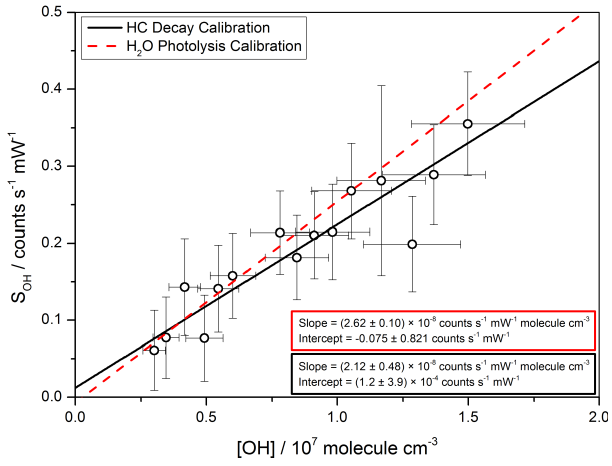
Figure 7. Calibration from the hydrocarbon decay method for cyclohexane at 1000mbar and 293K chamber pres- sure using the HIRAC FAGE instrument with the 200Hz PRF laser system; inlet pressure = (3.81 ± 0.02)mbar; laser power = (7.0 ± 0.5)mW; [H 2 O] vapour < 10ppmv. Extrapo- lated calibration from the H 2 O photolysis calibration tech- nique for inlet pressure = (3.79 ± 0.02)mbar, laser power = (6.0 ± 0.5)mW, [H = (3900 ± 20) ppmv and 2 O] vapour [OH] = (0.5–1.5) × 10 9 moleculecm − 3 . Both fits are weighted to errors in the x and y axes and error bars are representative of the standard error in the measurement to ± 2 σ . Uncertainties quoted for the slope and intercept represent the precision of the calibration processes to ± 2 σ